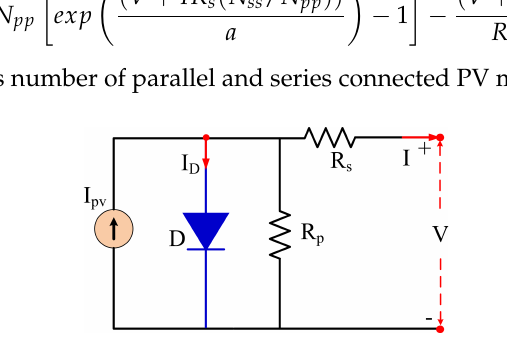
Figure 2. Equivalent circuit of single diode PV